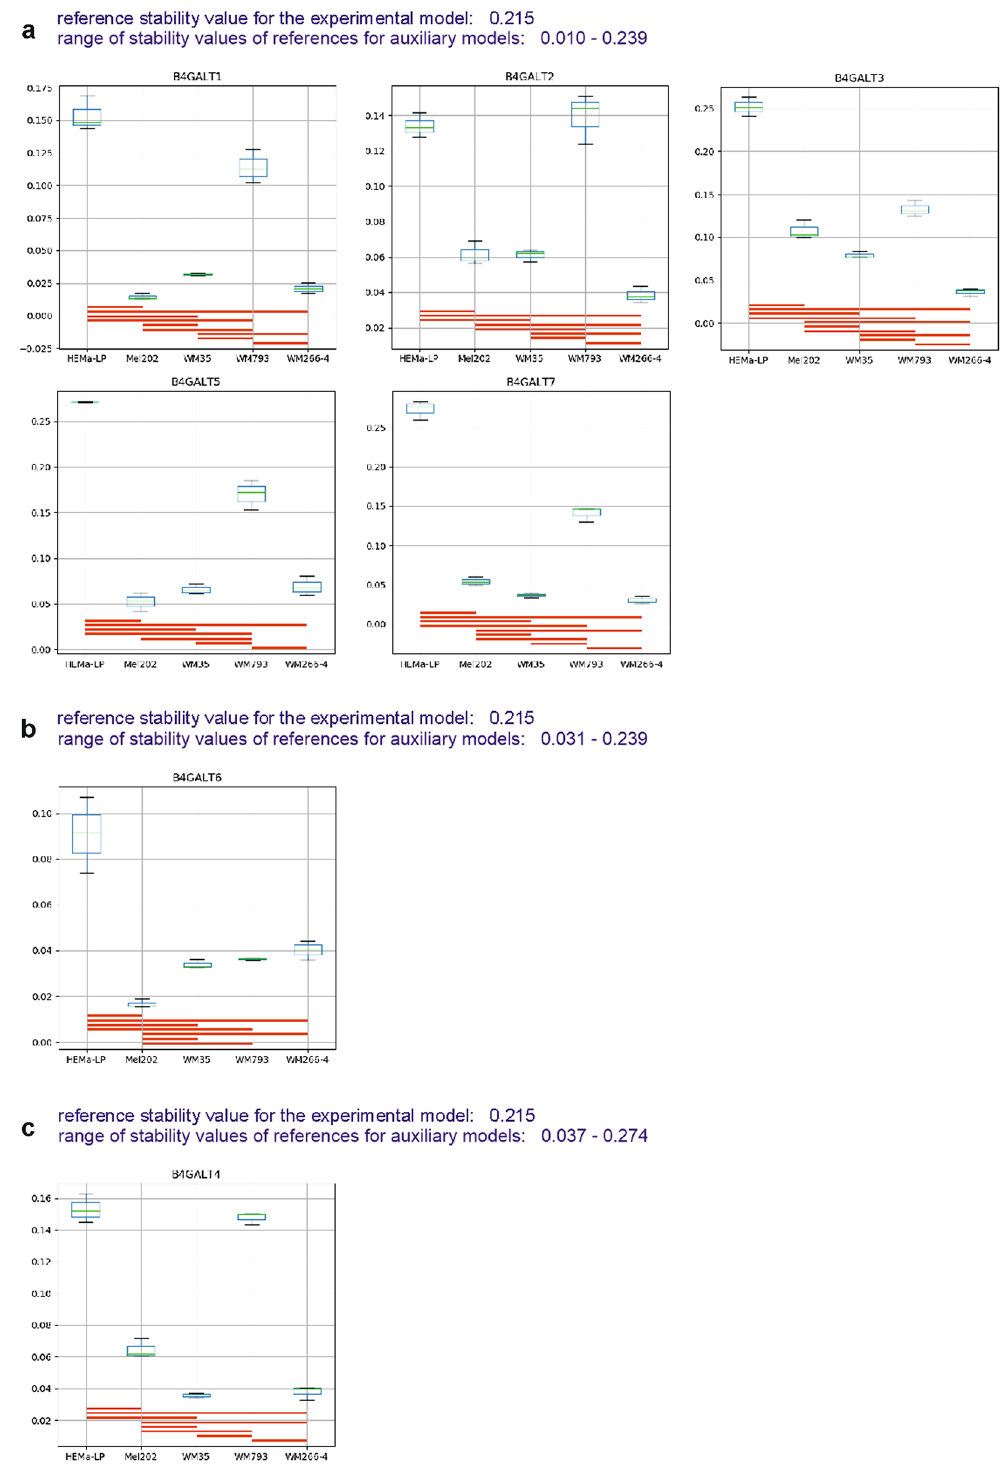
Figure 2. Medians of relative quantity (RQ) for target genes B4GALT1 – B4GALT7 in the experimental model normalized to a reference gene or pair of reference genes with the best stability values resulting from GenExpA analysis based on a set of five candidate reference genes and remove repetition level 2 ( a ) or remove repetition level 1 ( b ) or based on a set 3 ( c ) (see Table 1, part B). The statistical analyses used the pairwise t-test with Holm adjustment. Red line represents statistical significance, P <